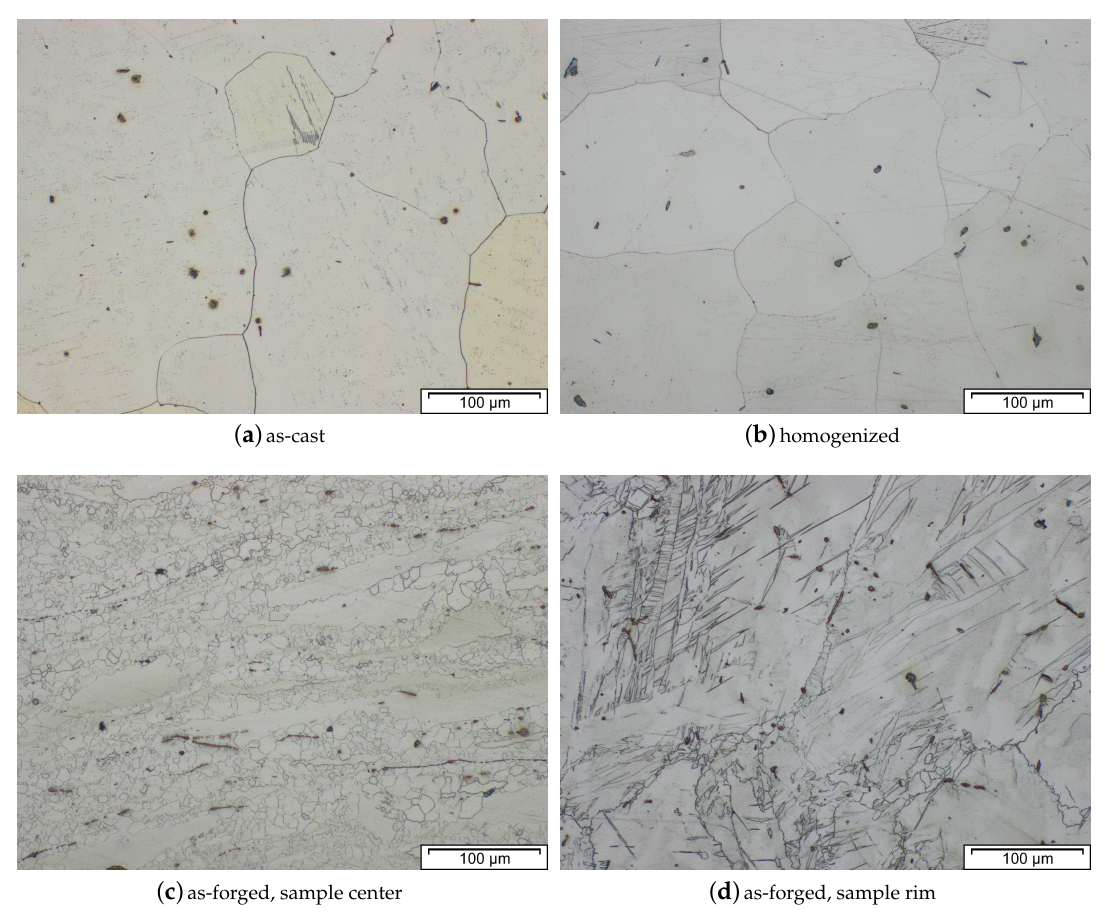
Figure 9. Microstructure of AZ31 in consecutive processing steps: ( a )as-cast, ( b )homogenized at 415 ◦ C for 24h. Forging took place using a material temperature of approx. 425 ◦ C, die temperatures of 280 ◦ C and a ram speed of 10mms − 1 . The as-forged microstructures of parts quenched in water are shown in: ( c )center area having high degree of deformation and ( d )flange area with a lower degree of